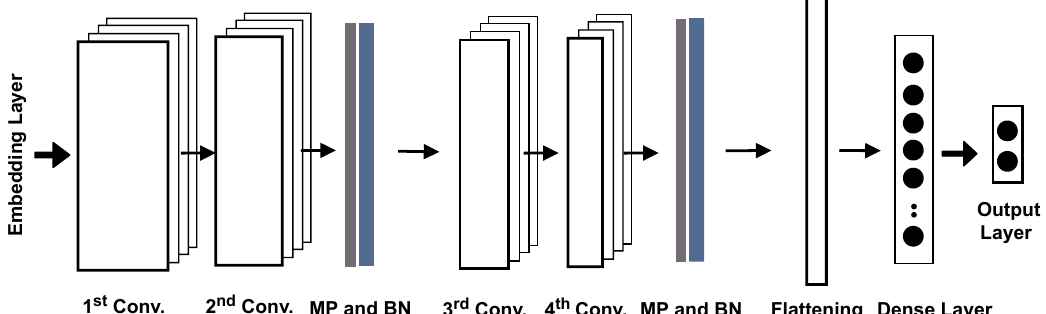
Figure 8. The structural design of the second approach. MP is the max-pooling operation, and BN is the batch normalization layer.